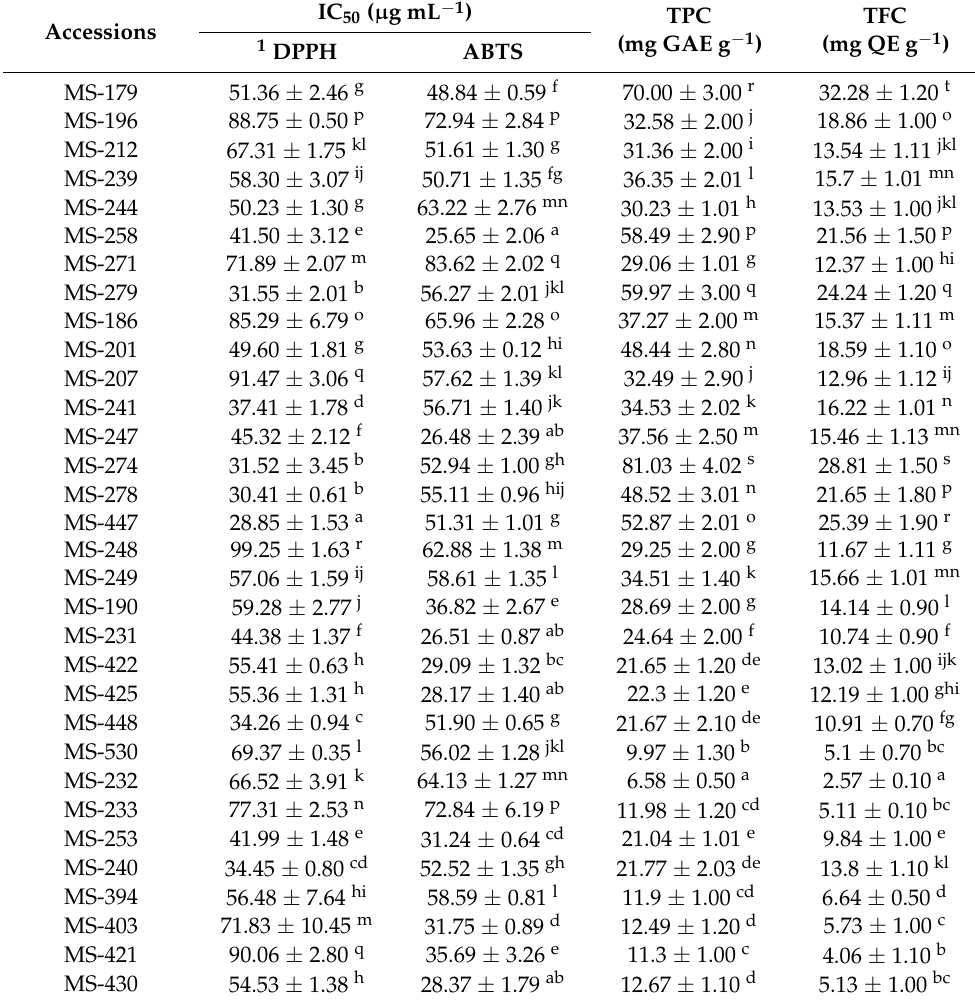
Table 5. Antioxidant activity of the selected M. sacchariflorus